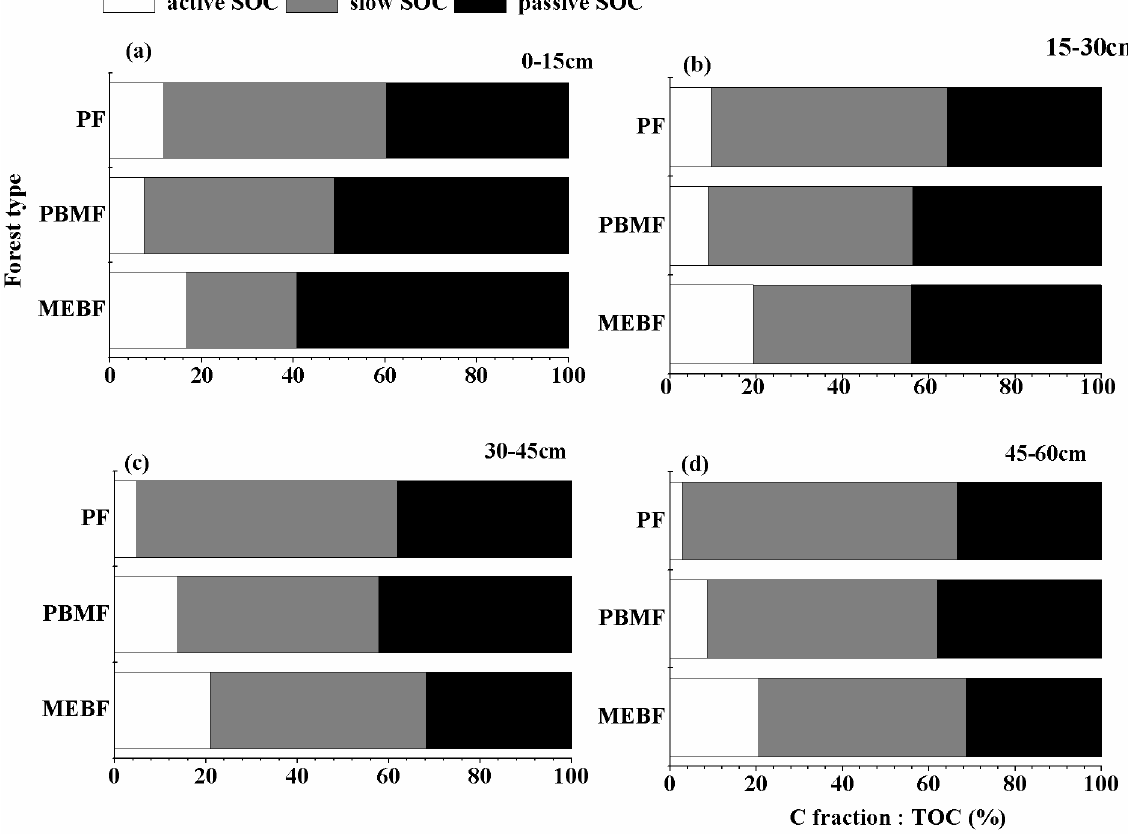
Figure 2. The proportions of different carbon (C) fractions to total organic carbon (TOC) in the three forests. PF: pine forest; PBMF: pine and broadleaved mixed forest; MEBF: monsoon evergreen broadleaf